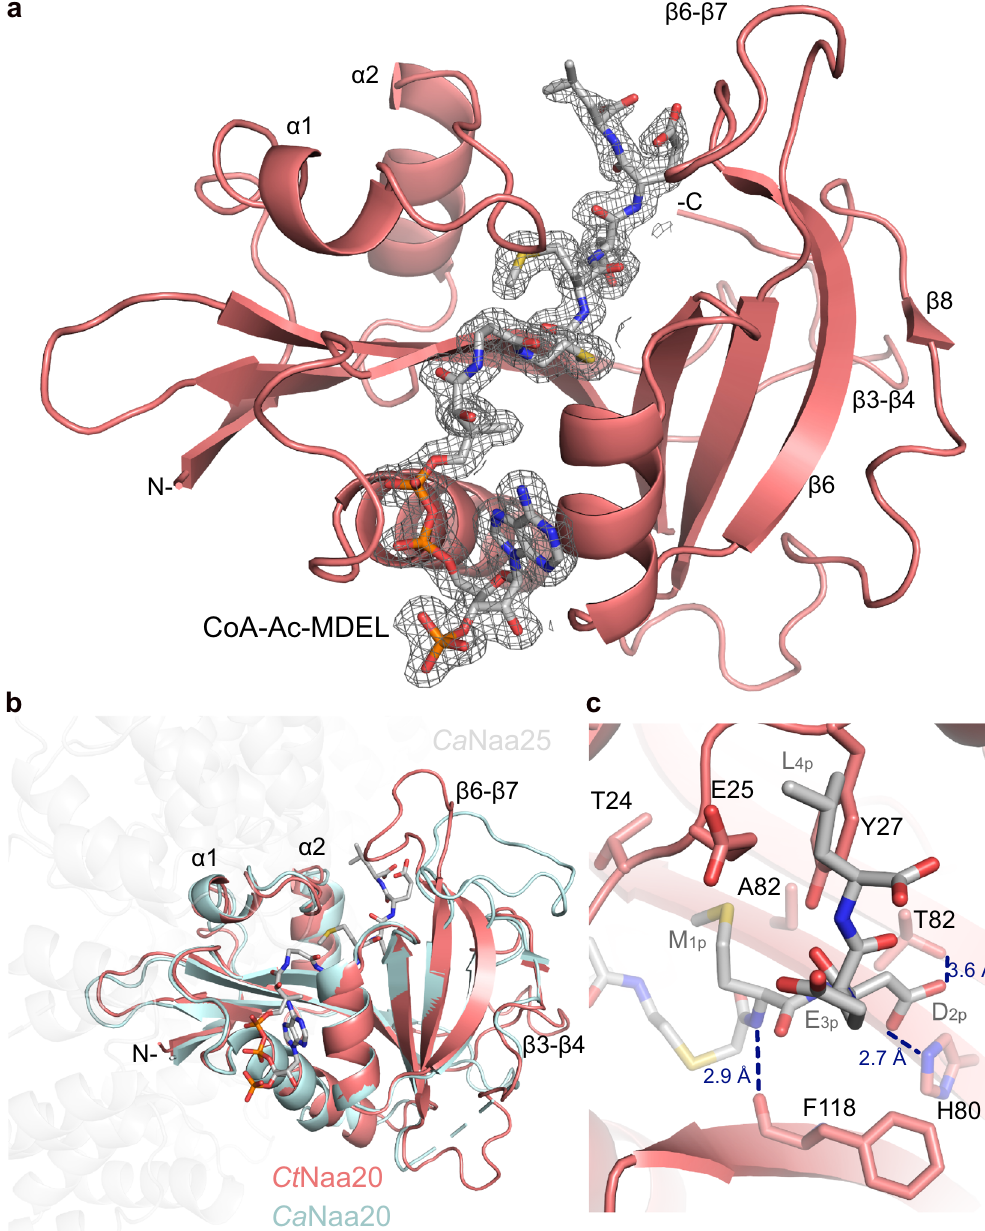
Fig. 4 Ct Naa20 crystal structure. a Overall structure of Ct Naa20 with CoA-Ac-MDEL. Ct Naa20 is shown in red as a cartoon and CoA-Ac-MDEL as gray sticks with nitrogen, oxygen, phosphorus, and sulfur shown in blue, red, orange, and yellow, respectively. The 2mF obs -DF cal electron density around the bisubstrate is shown at a contour level of 1 σ (gray mesh). b The Ct Naa20 structure is superimposed to Ca Naa20 as part of CaNatB (pdb: 5k18 30 ). Parts of the Ca Naa25 structure are shown transparent to clarify the orientation. c Hydrogen bonds between Ct Naa20 and CoA-Ac-MDEL are visualized with blue dotted lines and the corresponding atom